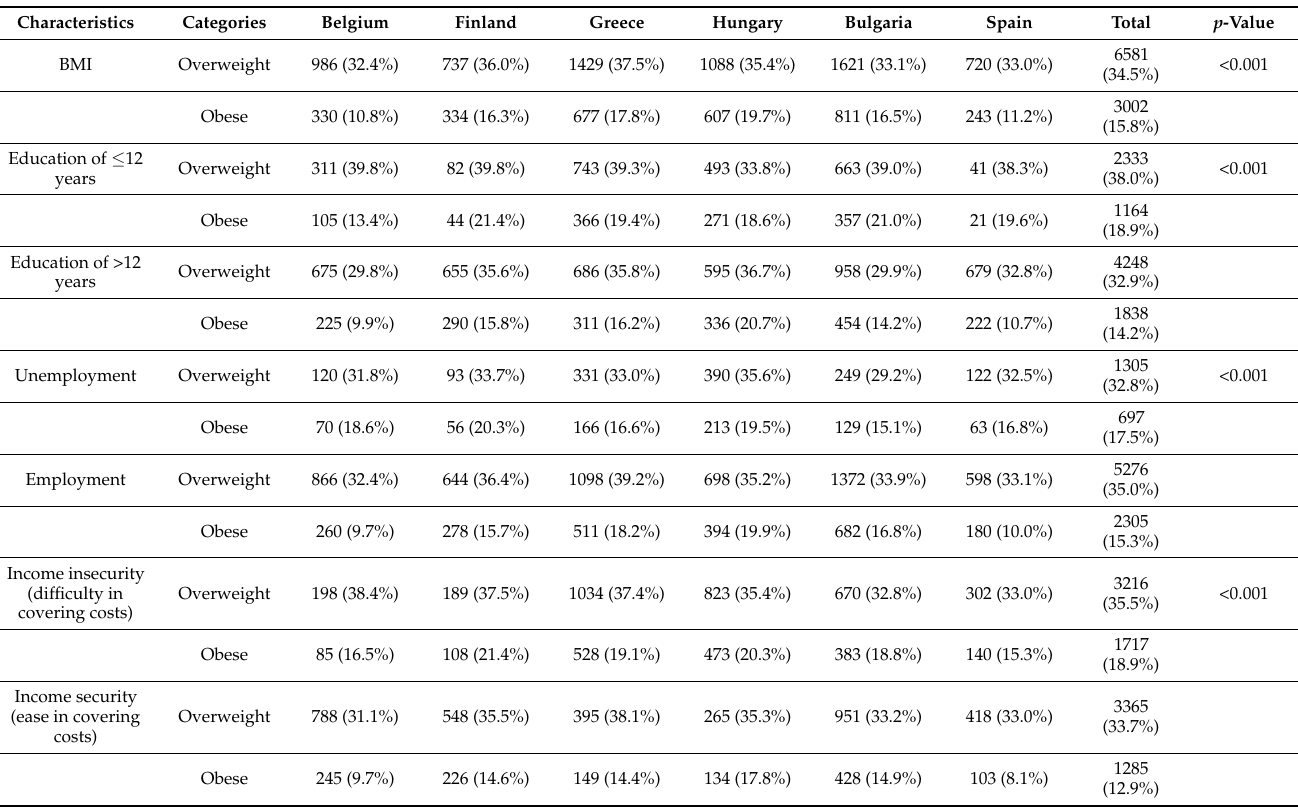
Table 2. Descriptive table of participants’ baseline weight status based on sociodemographic charac-